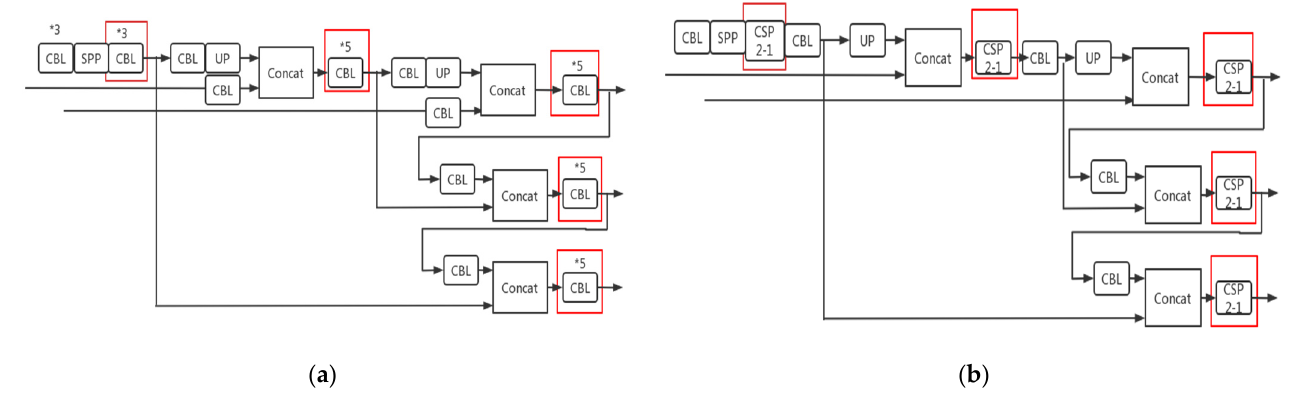
Figure 3. ( a ) Neck structure of YOLOv4; ( b ) Neck structure of YOLOv5.